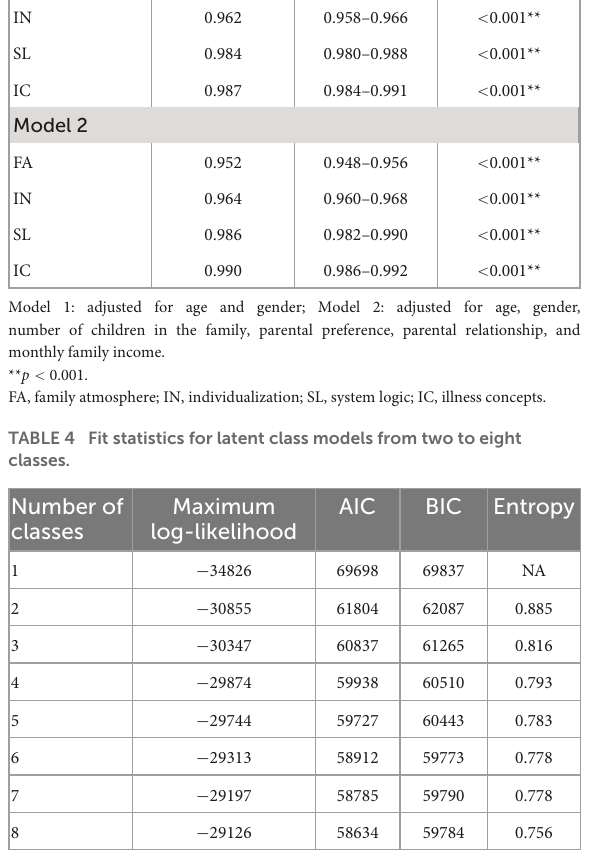
AIC,Akaikeinformationcriterion;BIC,Bayesianinformationcriterion.